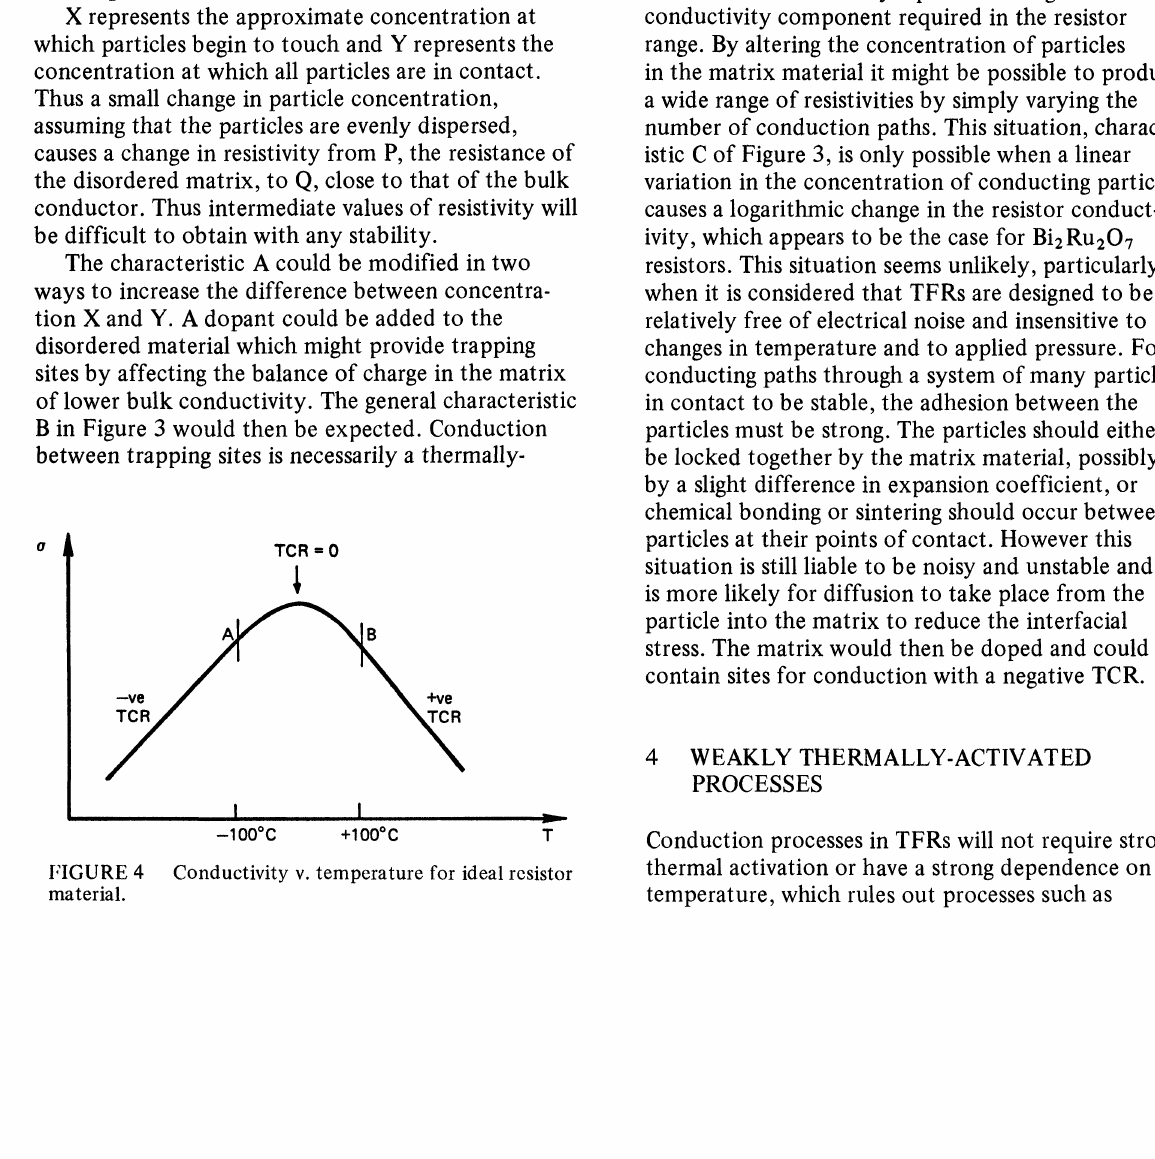
lnp v. particle concentration for particles in a matrix